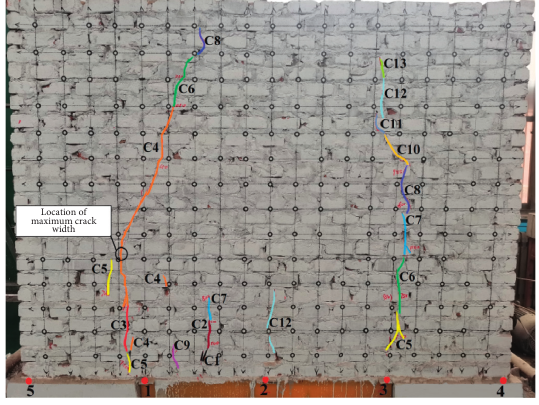
Figure 5: Distribution of wall